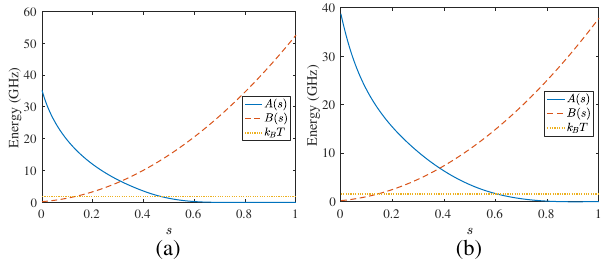
FIG. 9. Annealing schedules for (a) the DW2KQ and (b) the DW2X. The units are such that ℏ ¼ 1 . As a reference, we include the operating temperatures of the devices, corresponding to 14.1 mK for the DW2KQ and 12.5 mK for the DW2X. Note the different vertical axis